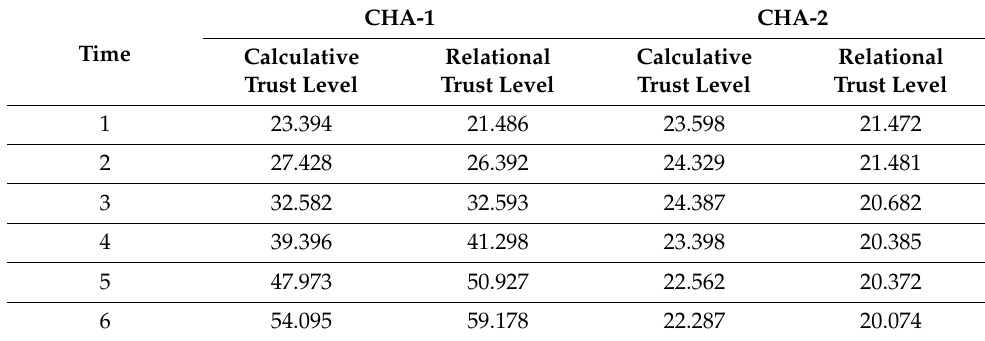
Table 6. Scenario E simulation